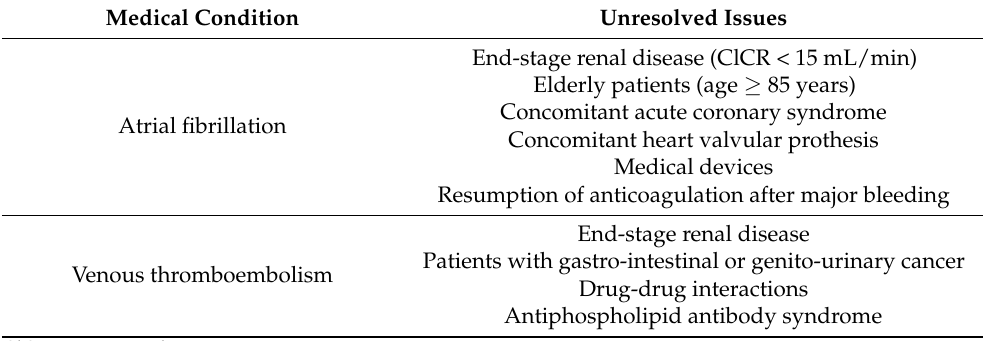
Table 1. Unresolved Issues in Established Indications for oral anticoagulation with potential indica- tion for antiFXI. Medical Condition